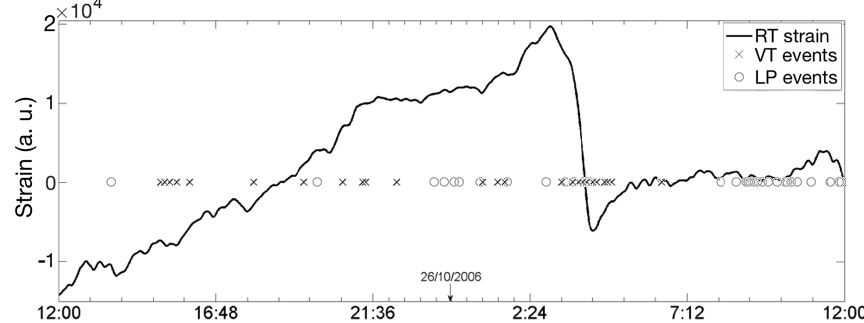
Figure 8. Strainmeter signal observed at RT. Crosses and circles on the zero axis show the time of occurrence of VT and LP events recorded near Solfatara. Tides and atmospheric pressure have been removed from the raw strainmeter data. An arbitrary datum has been used for strain.